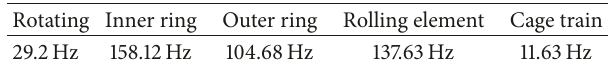
Rotating Inner ring Outer ring Rolling element Cage